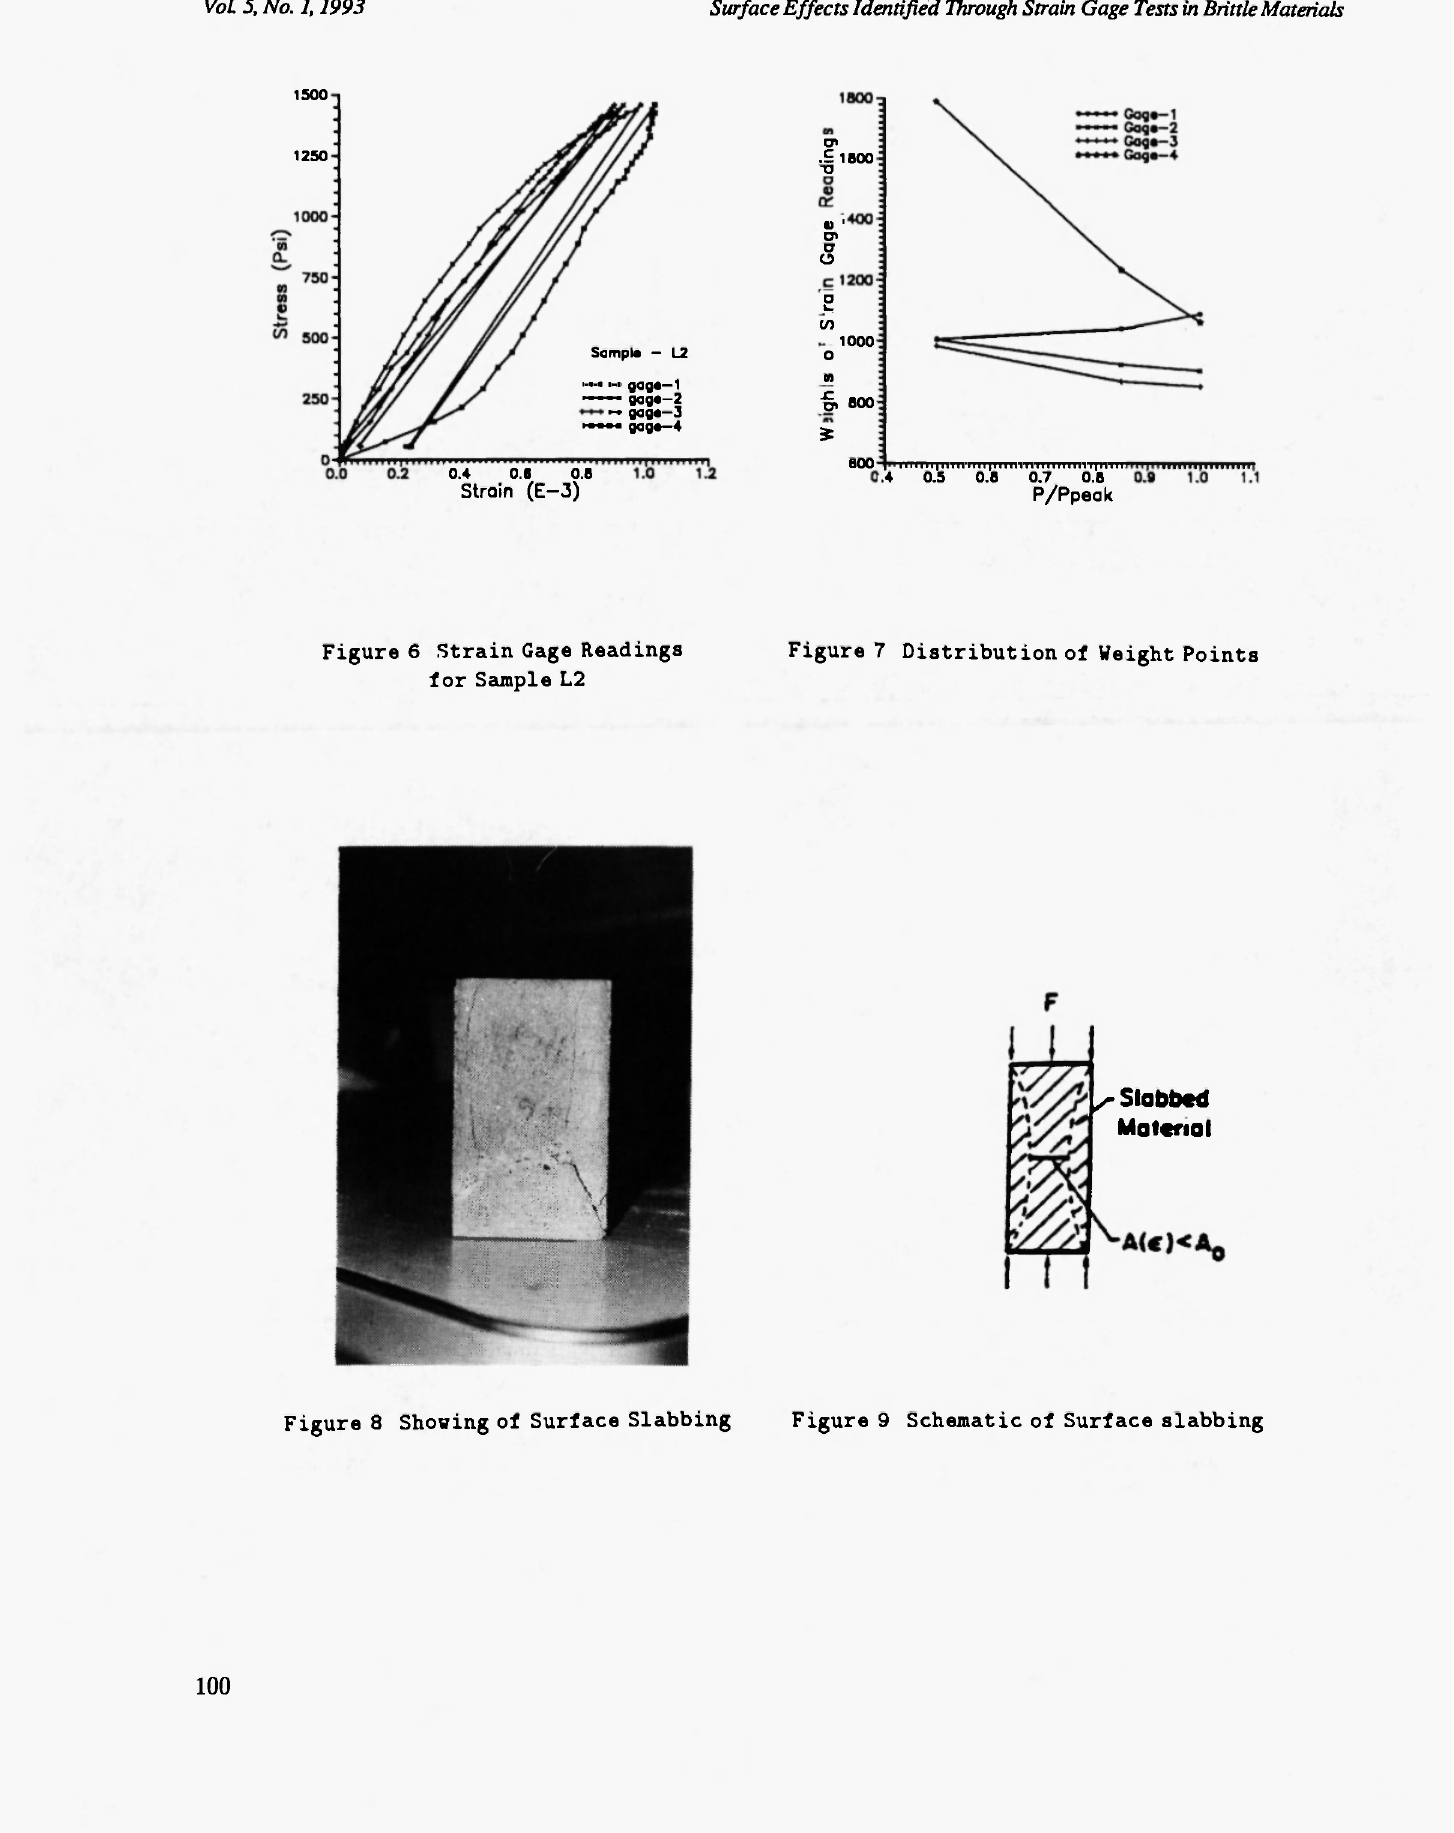
Figure 8 Showing of Surface